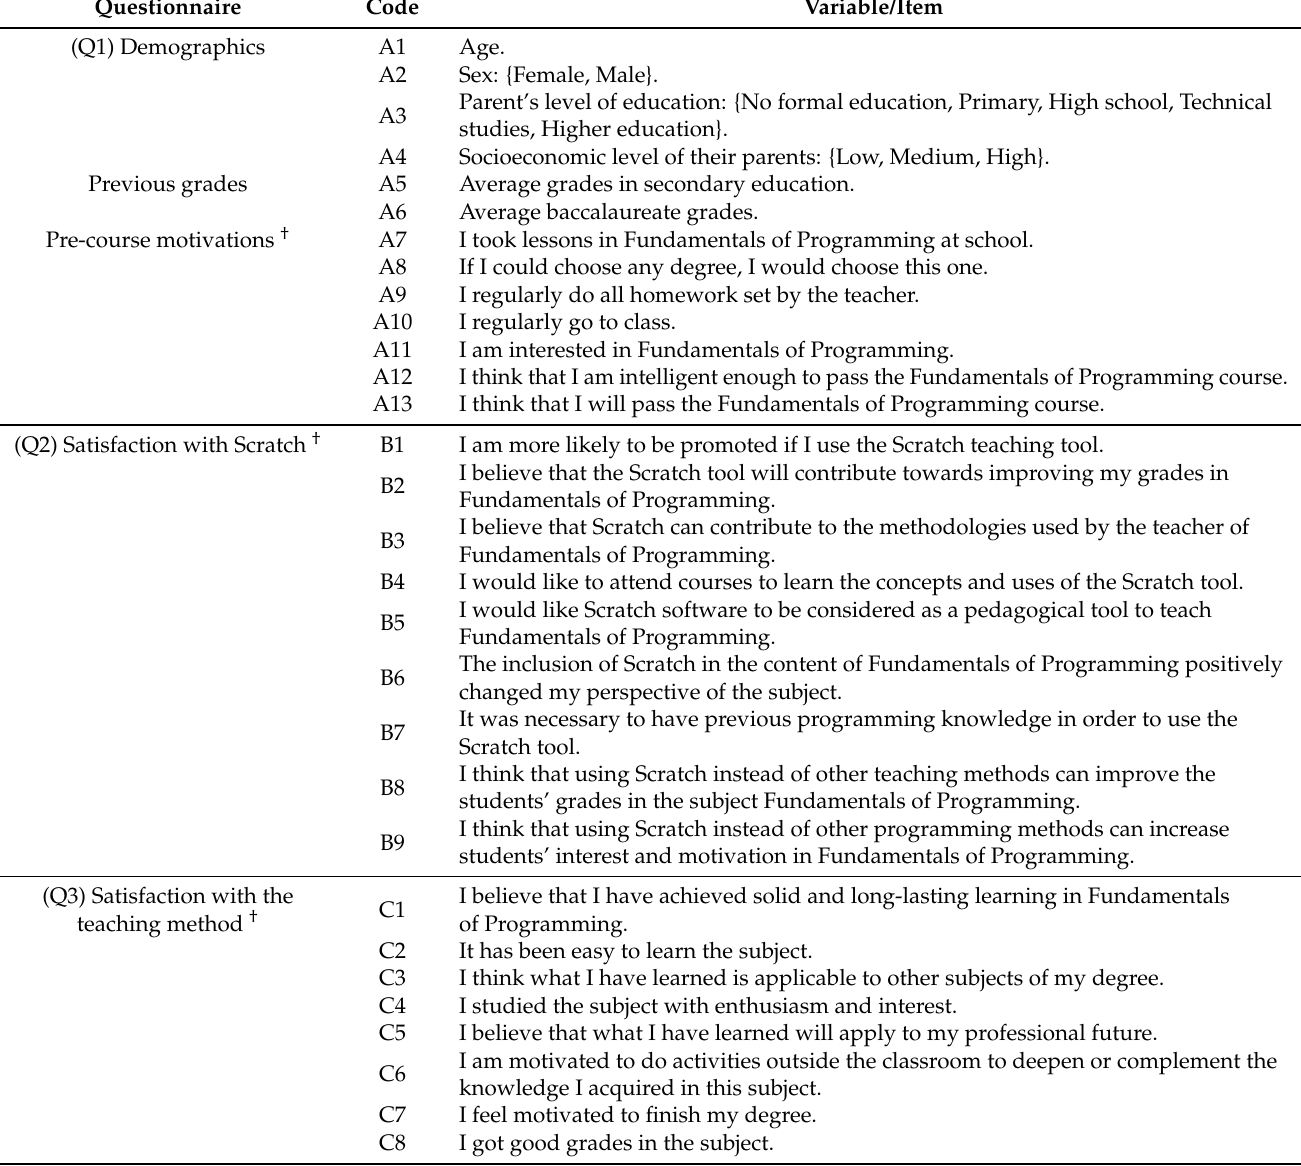
Table 1. Questionnaires used in this